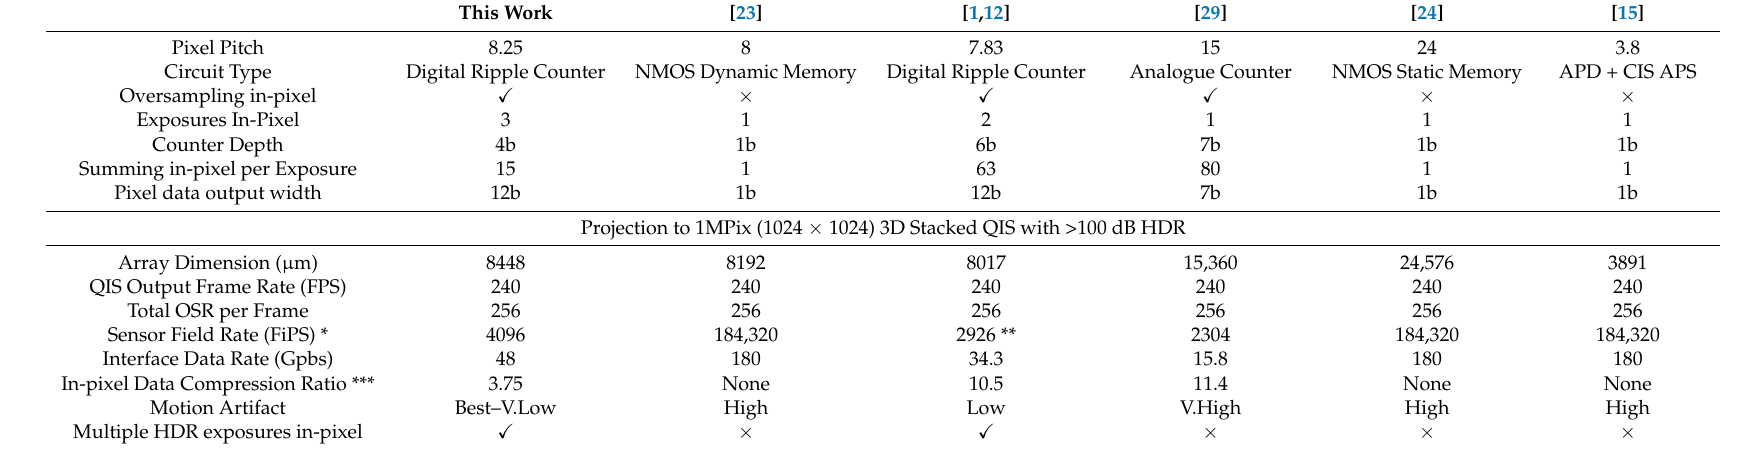
Table 4. Projection of different APD and SPAD pixel architectures to 1MPixel HDR QIS with ≥ 3 HDR field exposures.